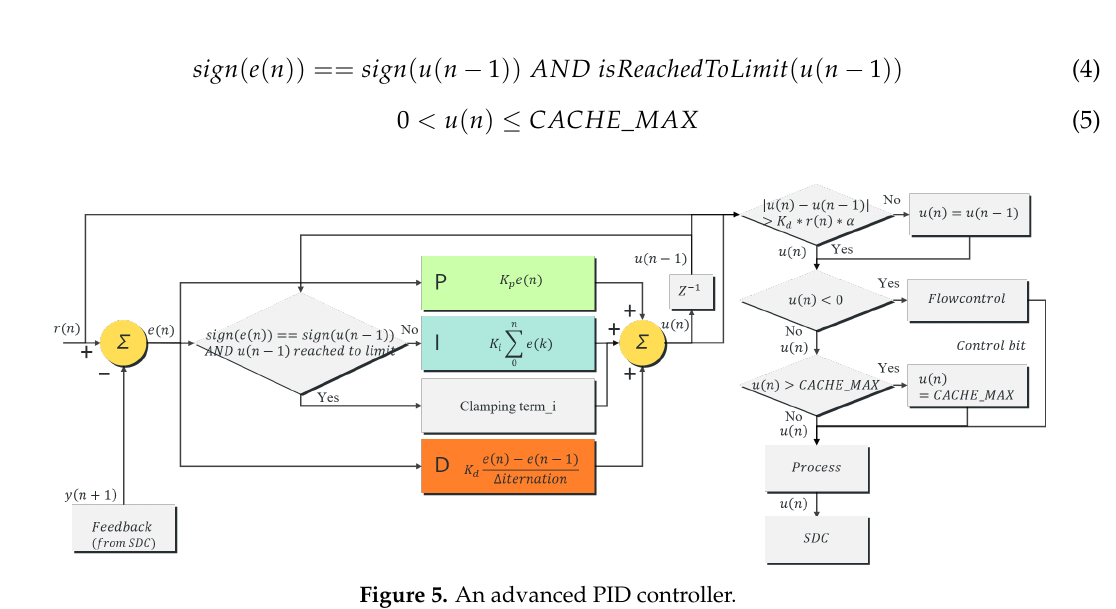
Figure 5. An advanced PID controller. Algorithm 1: compute() algorithm of EDCrammer to control caching rate for data